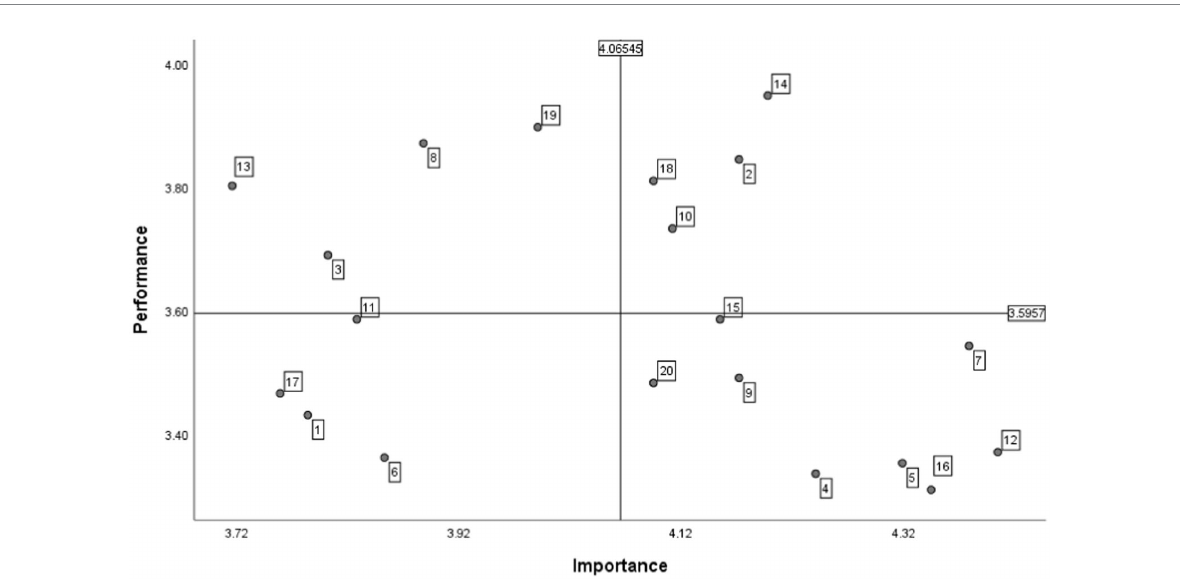
FIGURE 4 IPA analysis of satisfaction on public art classes in colleges and universities in the new media era. (1) The accessibility of public art education policy in new media; (2) the support of policy on public art education for the integration of new media and public art classroom; (3) the degree of implementation of public art education policy; (4) the degree of freedom of the upward feedback of practical issues; (5) the richness of new media resources; (6) the degree of new media’s allocation of cutting-edge resources; (7) the degree of interest and appeal of new media used in public